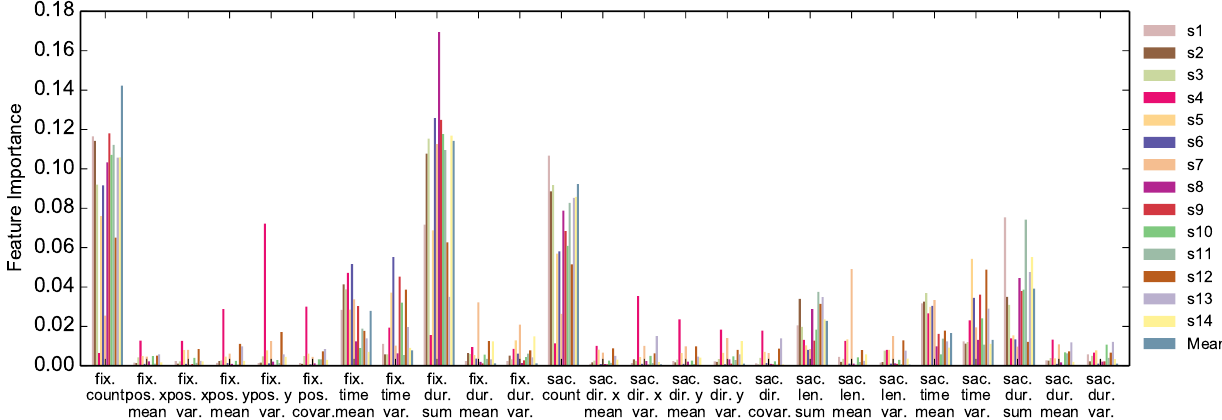
Figure 5 . Feature Importances obtained through training process of random forest classifier. The graphs correspond to the importances of the 25 features listed in Table 1 and are color-coded according to the training data